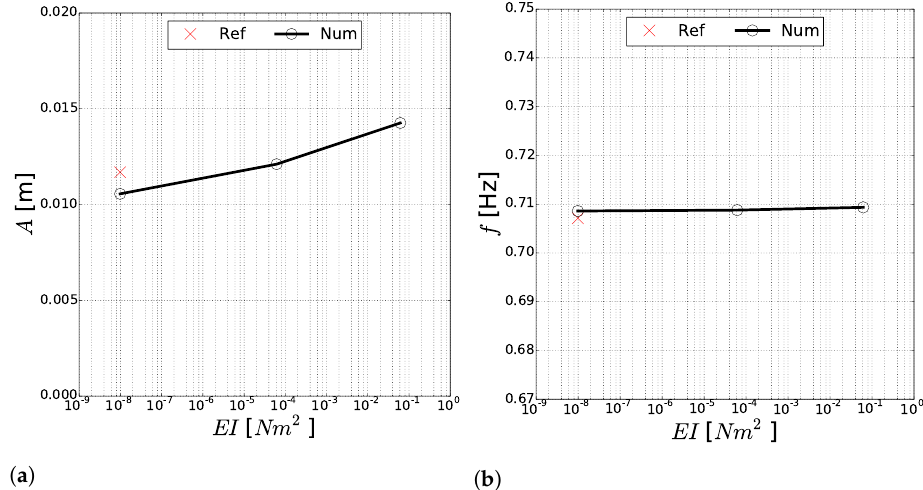
Figure 21. Parameter study of the effects of EI on the ( a ) amplitude and ( b ) frequency of the heave motion.